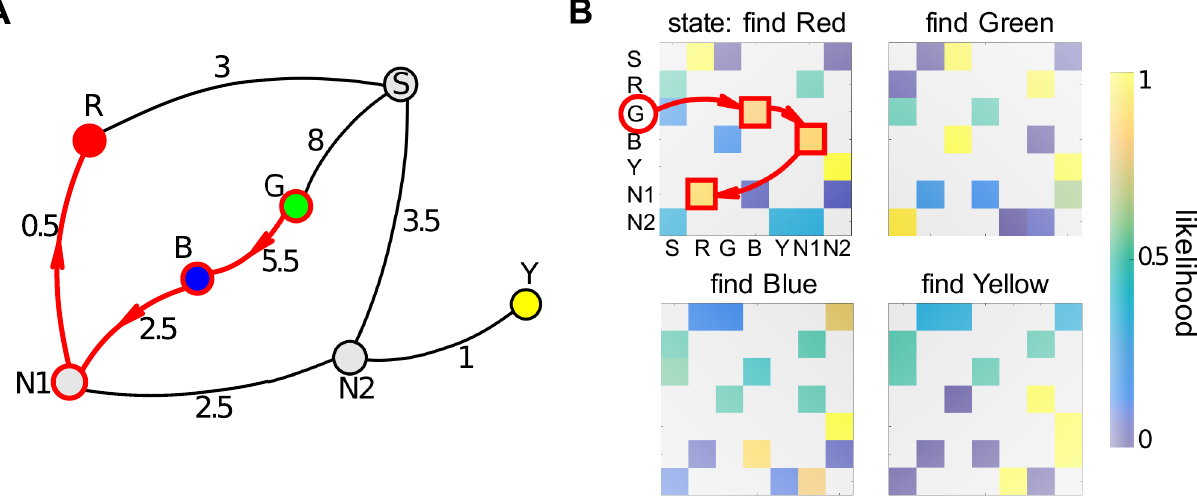
Fig 9. Constructing a learning matrix. A) A topological graph for Layout 1 including, along each edge, the distance (in metres) between nodes. Red arrows show an example of the participant’s task during the test phase: ‘go from Green to Red’. B) Likelihood matrices per target for one participant after they had completed the learning phase. These matrices show the likelihoods according to the rewarded-route model as described in the text. The highlighted elements of the matrix show the likelihoods of the steps shown in A.